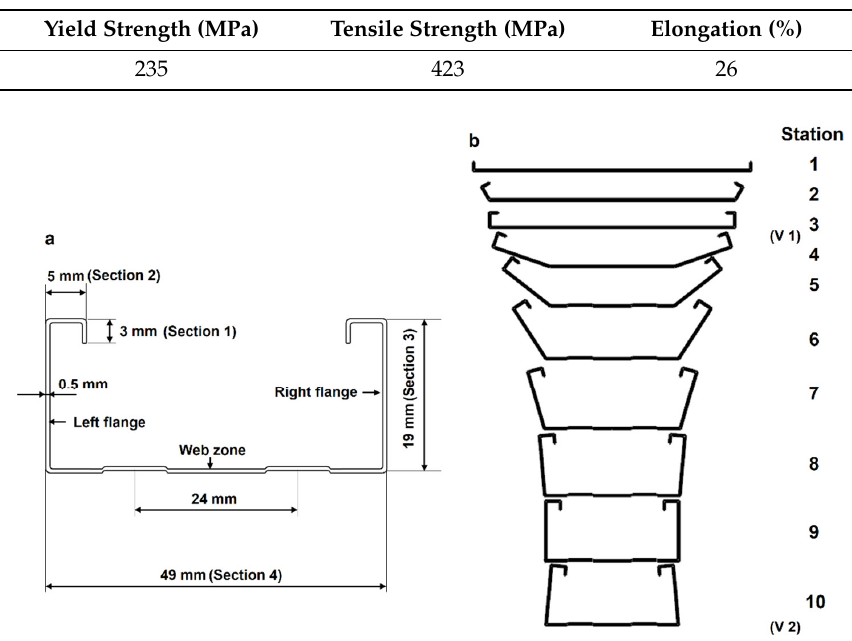
Figure 2. ( a ) The basic dimensions of C-channel steel; ( b ) Flower pattern.